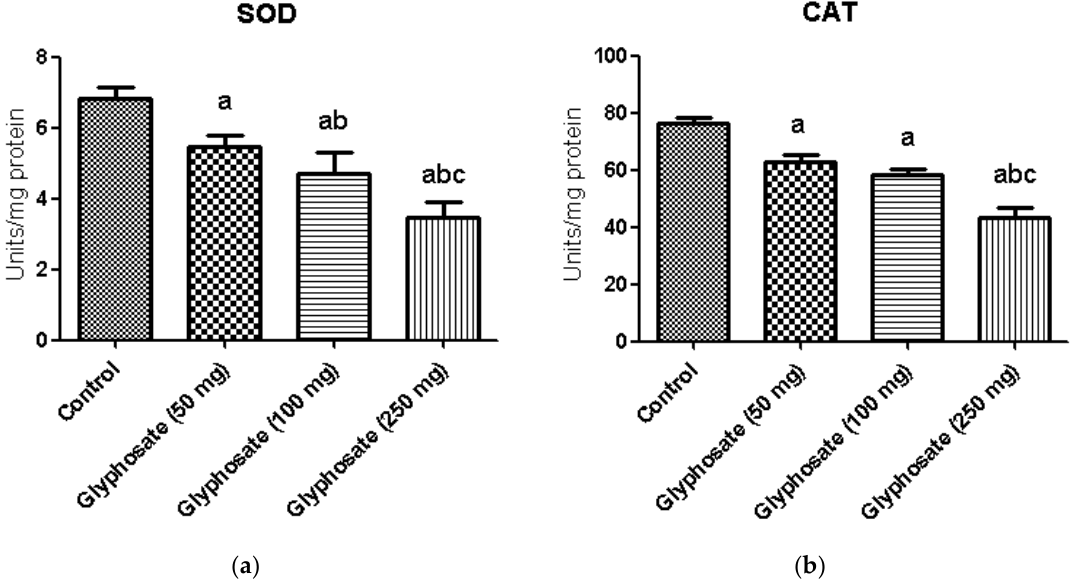
Figure 3. ( a , b ): The effect of glyphosate on antioxidant enzymes (SOD and CAT) in control and glyphosate treated rats. Data were expressed as mean ± SEM where n = 6 rats for each group. Values significant at p < 0.05 were analyzed with a — control, b — glyphosate (50 mg/kg b.wt.), and c — glyphosate (100 mg/kg b.wt.).